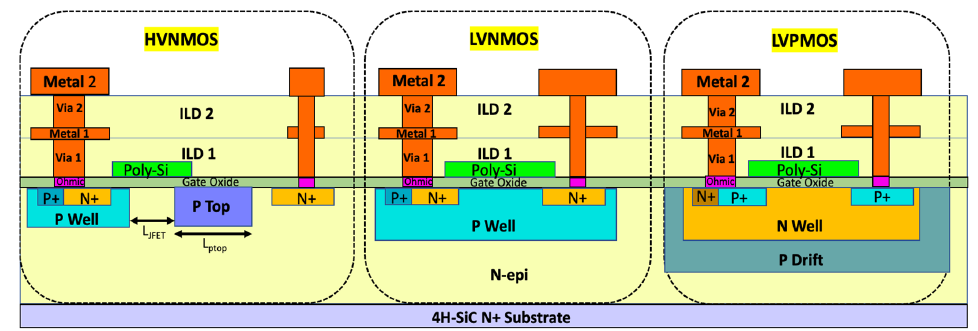
Figure 22. Cross-section of the fabricated HV NMOS, LV NMOS, and LV PMOS on an N-epi grown on N+ substrate. on N+